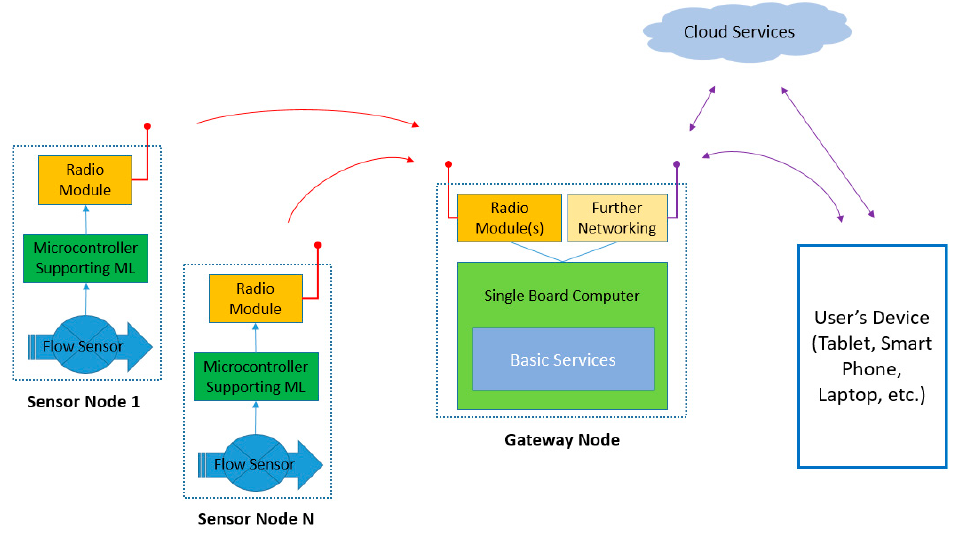
Figure 1. Functionality overview of the proposed water usage event characterization solution.